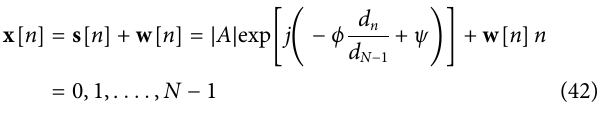
Example 1: The deception effect of the FDA counter the dual